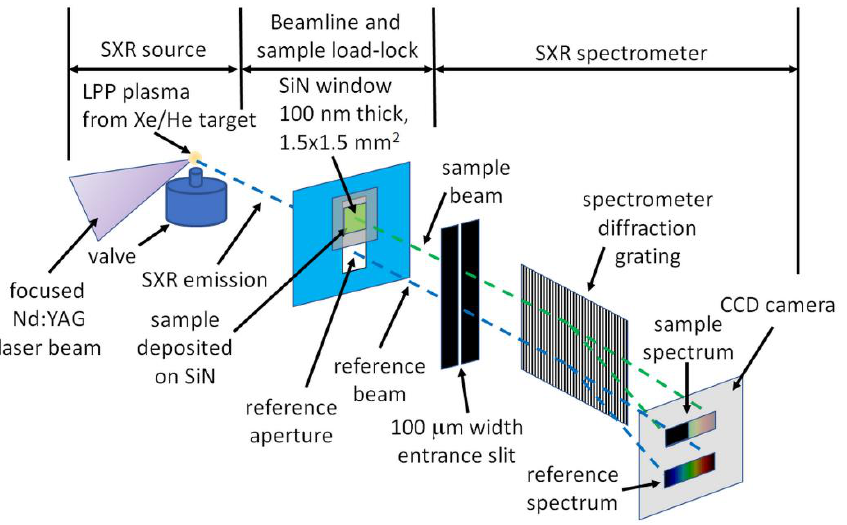
Figure 3. Scheme of the dual-channel SXR NEXAFS approach, indicating sample and reference SXR beams forming two independent spectra on the CCD camera. The spectra are used for the calculation of the OD spectrum.